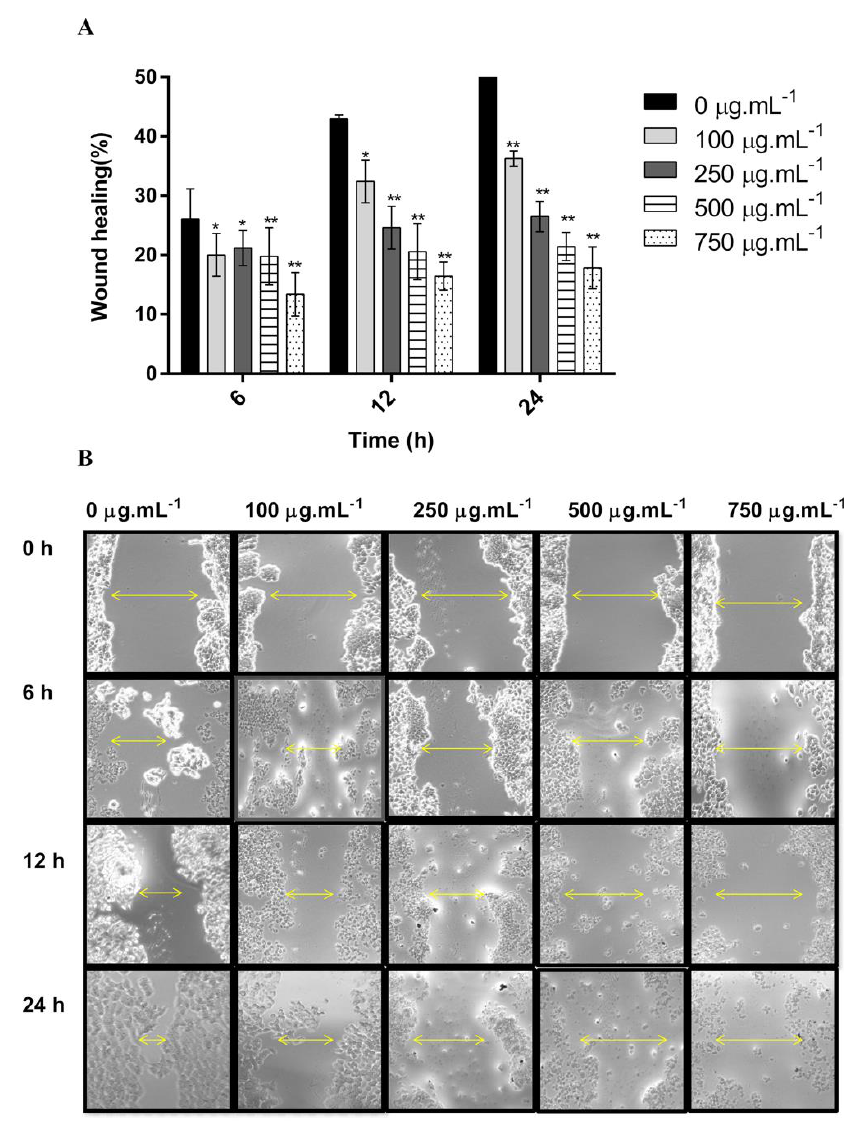
Figure 4. In vitro anti-migratory potentials of DM soxhlet extract on HCT-116 cell line migration analyzed by wound healing assay. “Wound” was created by a straight line scratch across the cancer cells monolayer: ( A ) Percentage of cell-covered area at 6, 12, and 24 h over 0 h as mean ± SD; ( B ) Representative images of two independent experiments done in triplicate. Significant differences are indicated as * p < 0.05 and ** p < 0.01 with respect to control.